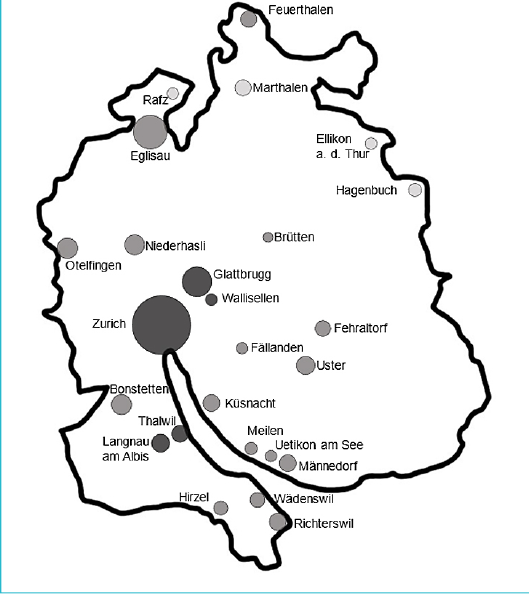
Figure 2: Areas from the canton of Zurich that were visited by the LuftiBus in the School (LUIS) study. The area of the circle is pro- portional to the number of participants per location. The colour of the circle indicates the degree of urbanisation of the region (from darker to lighter grey: large urban, small urban, rural areas) ac- cording to the Swiss Federal Office of Statistics classification. Defi- nition of urbanisation degree: cities or large urban area: at least 50% lives in high-density clusters. Towns and suburbs or small ur- ban area: less than 50% of the population living in rural grid cells and less than 50% living in a high-density cluster. Rural area: more than 50% of the population living in rural grid cells.